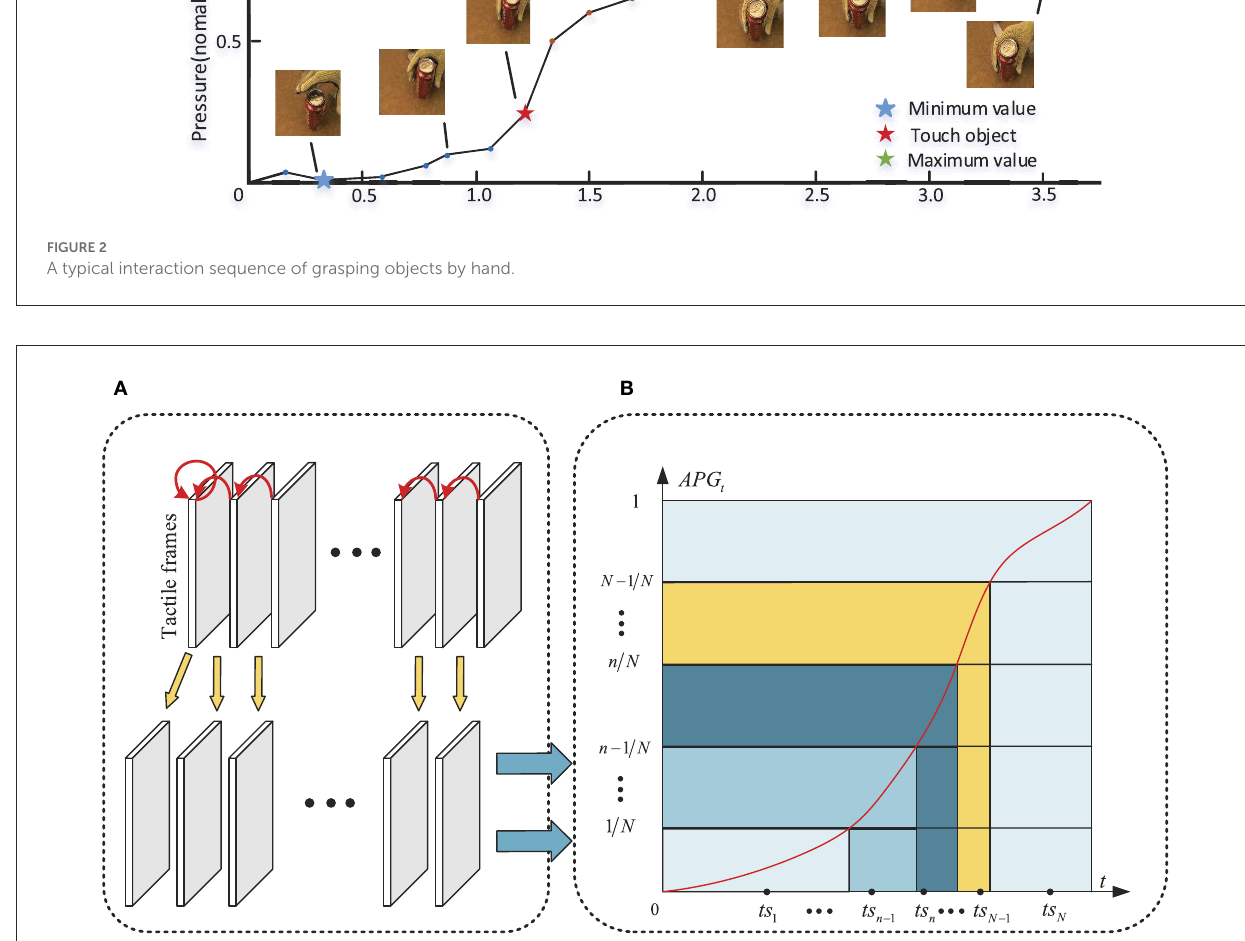
FIGURE3 Illustration of GAS strategy. (A) Gradient representation of tactile frames, (B) Accumulative gradient distribution with respect to time.